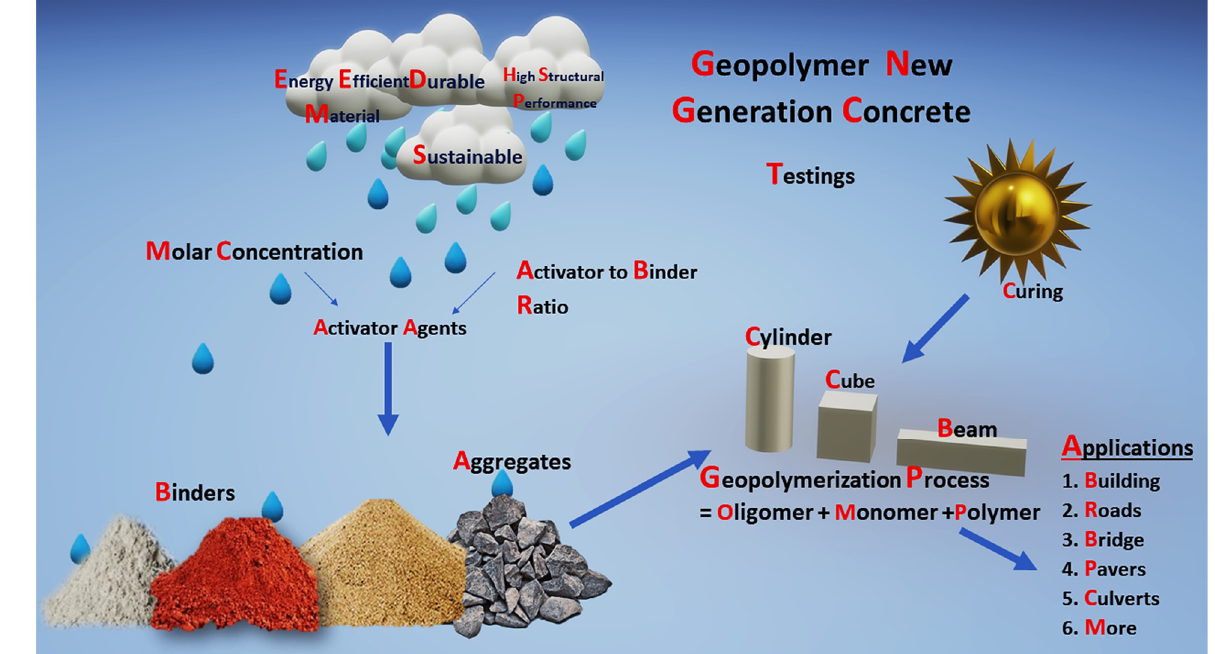
Figure 1. Geopolymerization process and its application.